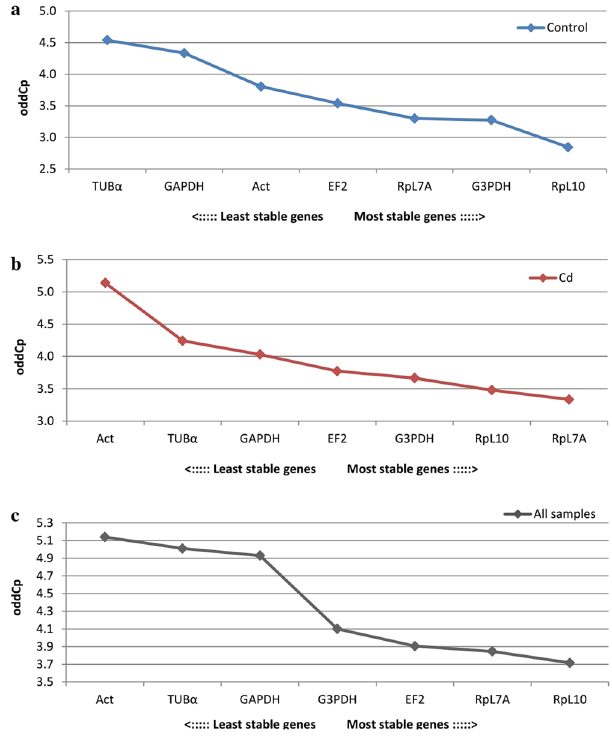
Figure 6. Expression stability of 7 candidate reference genes calculated by differences of crossing point-PCR- cycle values (oddCp = Cp max − Cp min ). Abbreviations as in Fig. 3.